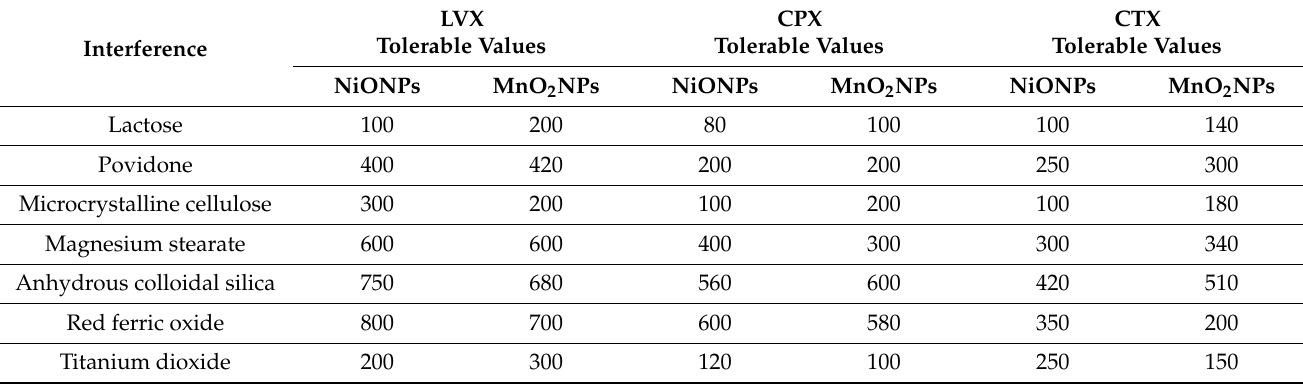
Table 4. Effect of foreign species on the determination of LVX, CPX, and CTX using the spectrophotometric method in the presence of NiONPs and MnO 2